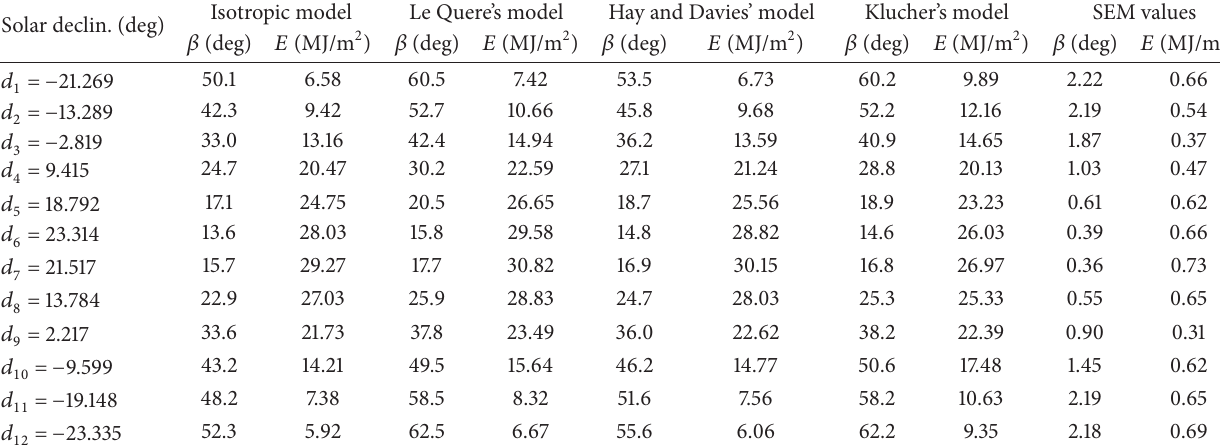
Table 2: Optimum tilt angle values and monthly mean of thedaily global solar radiation values computed by means of thealgorithm proposed in Section 2 applied to the monthly averages of the daily global horizontal solar irradiation data acquired from 1985 to 1989 at the site of Athens (latitude +37 ∘ 58 󸀠 N; longitude +23 ∘ 43 󸀠 E).